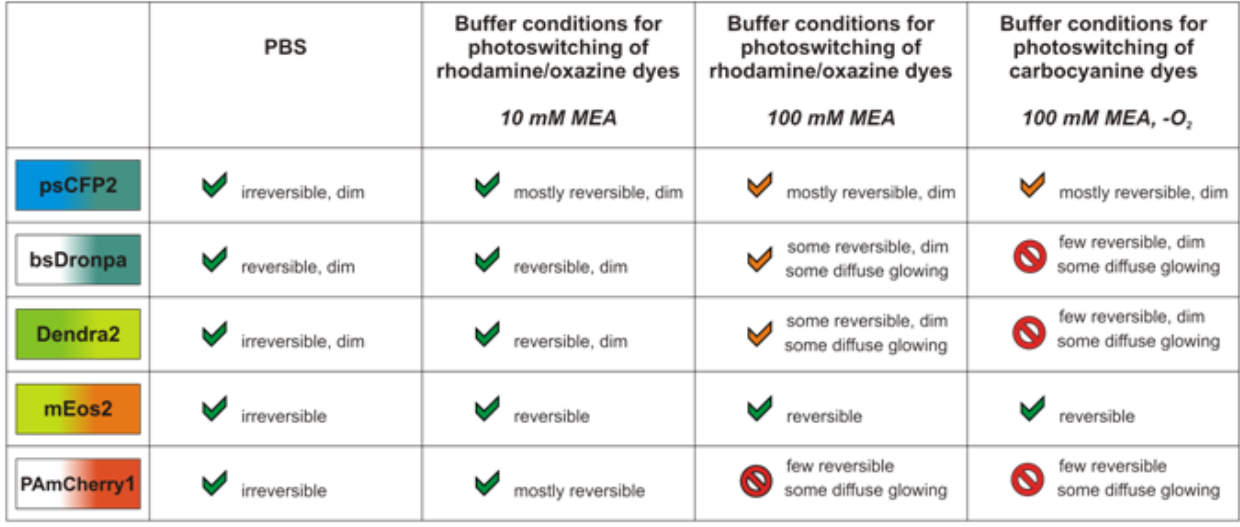
Table 2. Summary of suitable buffer conditions for the fluorescent proteins tested and with respect to organic fluorophore